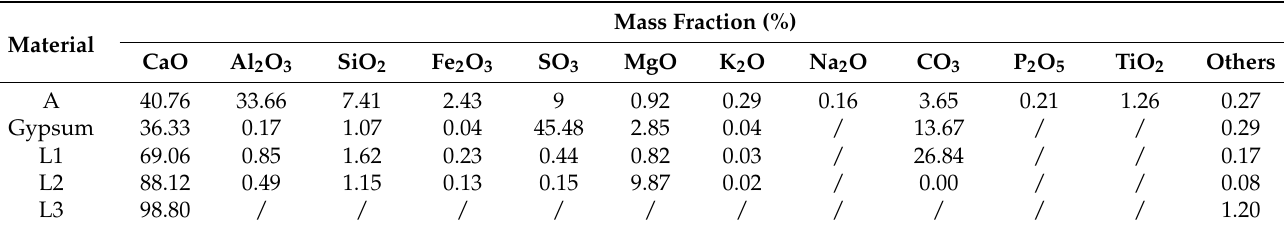
Table 1. Chemical composition of material A, gypsum, L1, L2, and